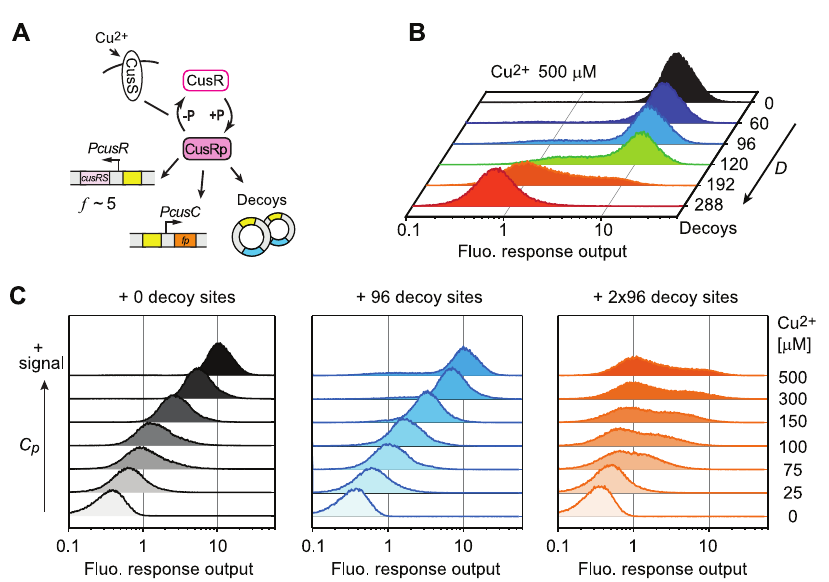
Fig 8. Bistability in the CusRS system depends on the signal strength and the number of CusR DNA binding sites. (A) Experimental design for exploring bistability in the CusRS system. A chromosomal PcusC-mGreenLantern reporter was used to track the response to environmental Cu 2+ concentration and plasmids carrying different number of decoy CusR binding sites were used to alter the number of DNA binding sites. (B and C) Flow cytometry analyses of YFP reporter output in response to different numbers of DNA decoys (B) and different Cu 2+ concentrations